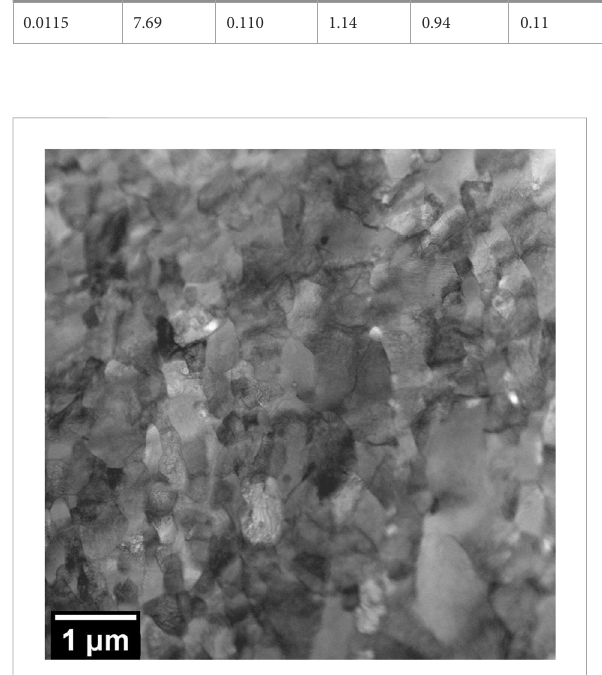
FIGURE 1 A tempered martensitic structure of the as-received sample with fi ne grains in TEM.